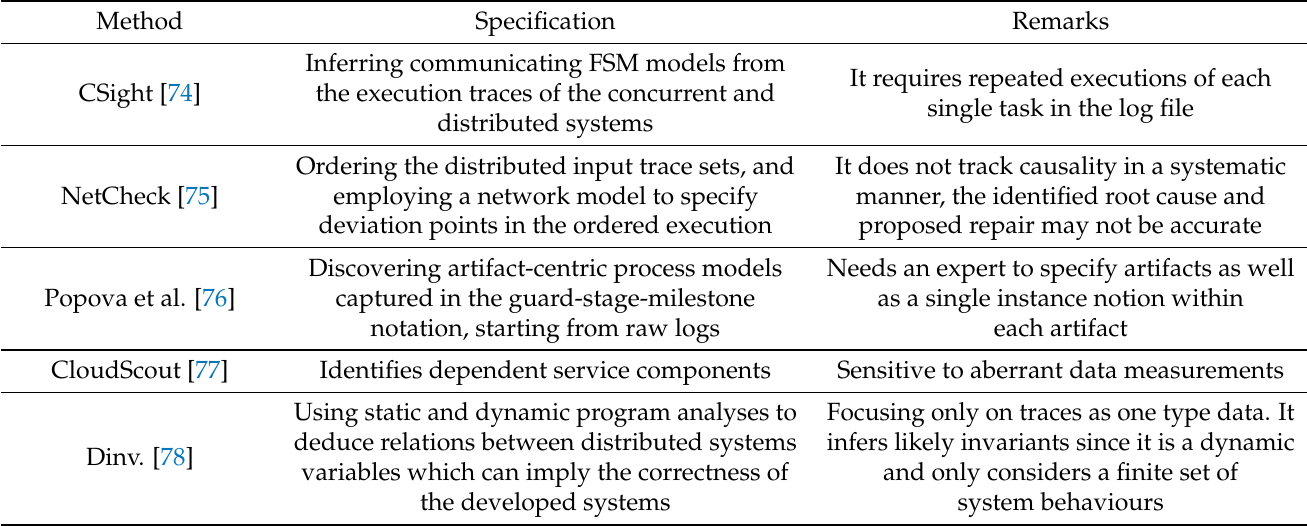
Table 7. Different approaches of multi-service dependency from application level